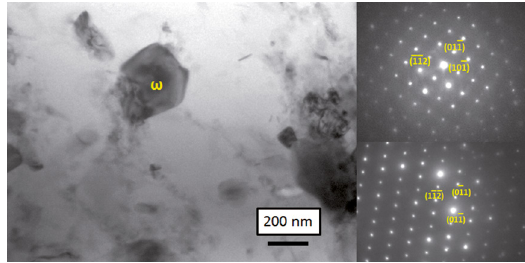
Figure 4: TEM bright field image (a) of the 2124/AlCuFe composite and two selected area diffraction patterns taken from the reinforcing phase (b) and (c).